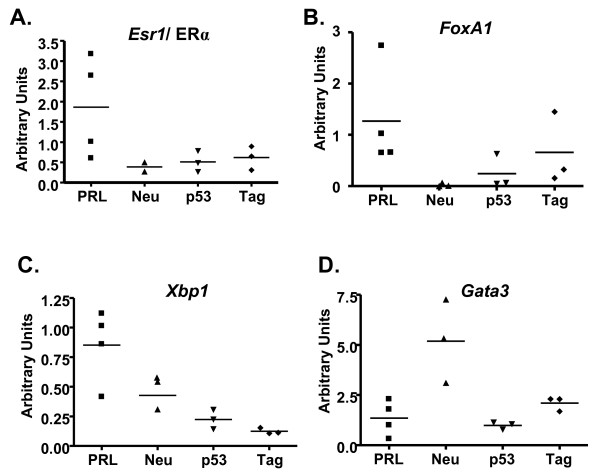
PRL-induced adenocarcinomas display molecular features of luminal clinical breast tumors. (a-d) RNA from mammary carcinomas that developed in NRL-PRL, MMTV-neu [28], C3(1)-SV40 Tag [29], and transplanted p53-/- (O'Leary and Schuler, manuscript in preparation) models was examined for levels of transcripts comprising the luminal signature [31] by qRT-PCR as described in the Materials and Methods. PRL-induced papillary adenocarcinomas were of diverse ERα status by IHC. Each symbol denotes a distinct tumor. The horizontal bar indicates the mean level for each model.